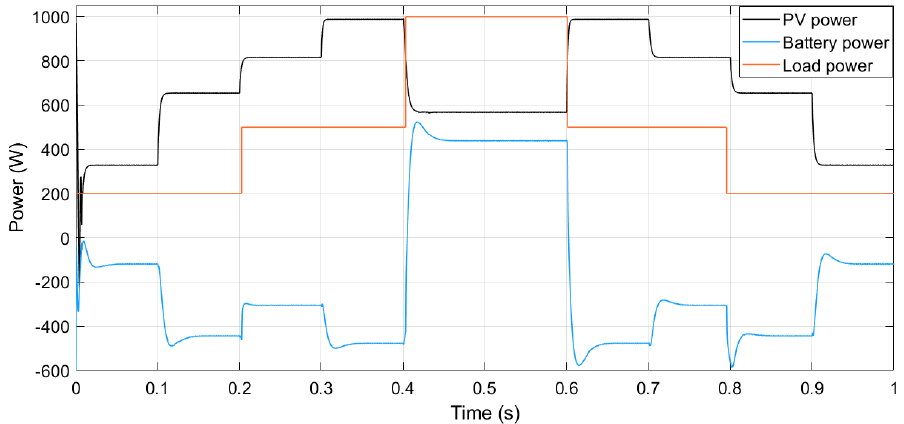
Figure 9. PV power, battery power, and load power.